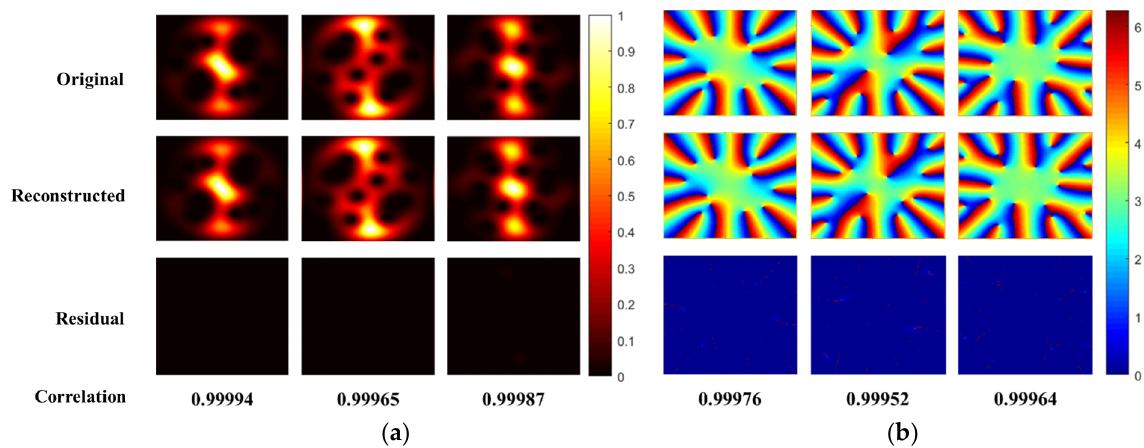
Figure 3. Comparison of the reconstructed image with the original image for 9 modes of superimposed LG beams. ( a ) Image comparison of mode weights; ( b ) Comparison of mode phase maps.